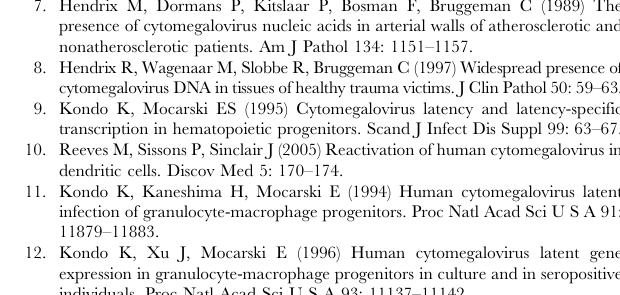
Ki67 expressing T cells from the populations shown in ‘‘B’’. Error bars represent the standard error of the mean. Statistical significance was measured by a paired student’s t-test (*p , .05, **p , .01). Figure S4 FTY720 treatment does not alter the mainte- nance of memory inflation. (A) Inflationary populations express low levels of CD62L. Representative FACS plots show expression of CD44 and CD62L on M38-specific (left) and IE3- specific (right) cells in the blood more than 3 months post infection, but prior to any FTY720 treatment (as in Figure 3). (B–D) The IE3-specific T cell population is stable in the blood of mice during prolonged FTY720 treatment. Shown are the IE3-specific populations from the experiment illustrated in Figure 4 indicating (B) the number of IE3-specific CD8s per milliliter of blood, (C) the percentage of blood-localized IE3-specific CD8s expressing the effector phenotype (KLRG1 pos , CD127 low ), and (D) the frequency of Ki67-positive IE3-specific CD8s in the blood before and during the time course in treated mice (top) and controls (bottom). Error bars represent the standard error of the mean (n= 5 per group). Statistical significance was measured by paired (B–D) student’s t- Figure S5 Intravenous staining reveals cells that are exposed to the blood supply. Mice infected with K181 MCMV for more than 3 months were injected with APC-labeled anti-CD8 a antibody to identify T cells exposed to the blood supply. The localization of staining was confirmed with immuno- fluorescent staining of tissue sections. (A) In the spleen, CD8s labeled with injected antibody (white) were localized to the red pulp (identified by F4/80 expressing macrophages-shown in red) and were not found in the white pulp (delineated by B220 shown in green). The enlarged inset (1) shows overlaid lines between the red pulp and the white pulp and the arrow indicates one of several i.v. labeled CD8s in the red pulp. (B) Staining of lung sections revealed that all CD8s labeled by injected antibody (shown in white – marked by arrows in enlarged images of insets 2 and 3) co- localized with vasculature (identified by CD31 expression - red), while aggregates of lymphocytes (identified by CD45.2 expression – green) and cells in the airways that were outside the vasculature remained unlabeled. Note that many of the cells in the CD45 + aggregate (inset 3) were identified as T cells in a serial section (not shown). (C) Within mediastinal lymph nodes, i.v. stained CD8s (shown in white – marked by arrows in the enlarged images of inset 4) were only found in association with the lymph node vasculature (CD31 + , shown in red) while CD8s outside of the vasculature (identified by CD8 b expression – green) were unlabeled by the i.v. antibody. (D) In the liver, T cells that were labeled with i.v. injected anti-CD8 a (shown in white – marked by